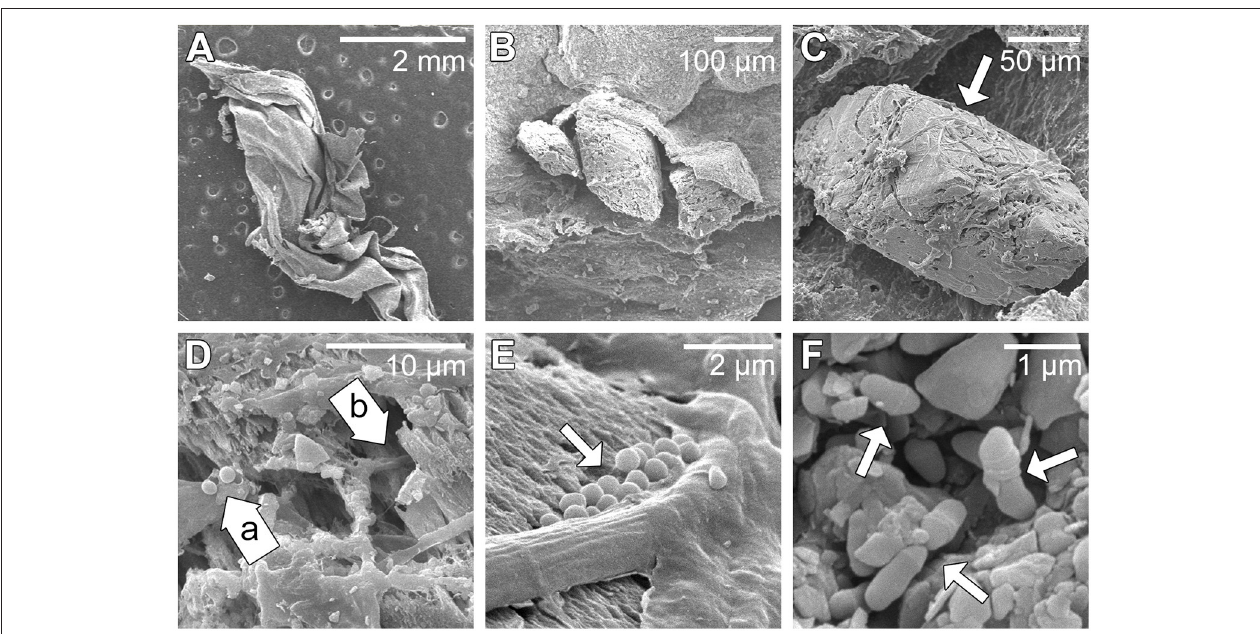
FIGURE 2 | Scanning electron microscopy images of paleomat collected upslope from Lake Vanda. (A) Low magnification of desiccated paleomat flake. (B) Paleomat flake attached to porous sediment grain. (C) A close-up of porous grain with attached microbial filaments indicated by the arrow. (D) Coccoid cells (a) and filamentous microbial cells (b). (E) Close up showing filaments, rod and coccus cells (indicated by arrow). (F) Rod-shaped or club-shaped cells (indicated by